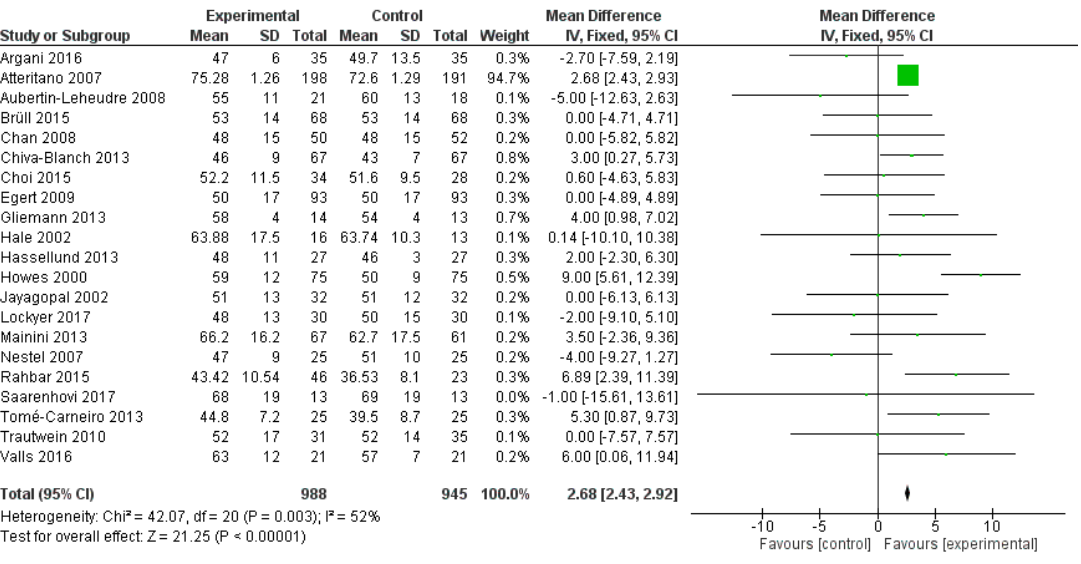
Figure 5. Pooled analysis of association between polyphenol intake and low-density lipoprotein cholesterol (LDL-C). FMD was reported in eight studies, for a total of 568 patients (289 treated with polyphenols and 279 with placebo). The polyphenol administration significantly increased FMD (mean difference 0.89%, 95% CI: 0.40, 1.38%, p < 0.001) (Figure 6).